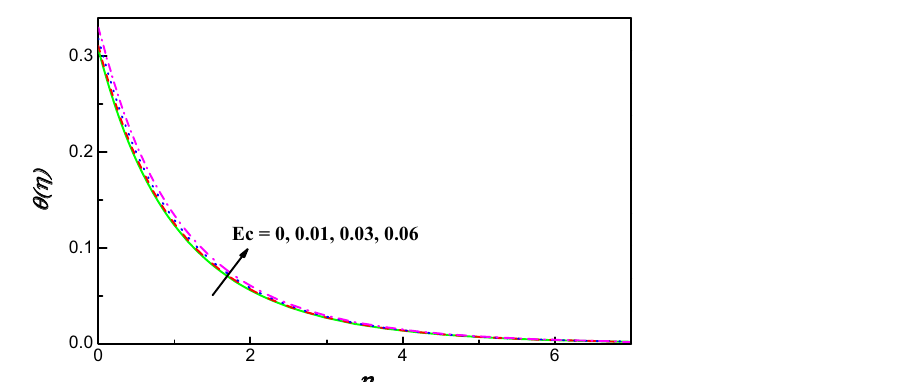
Figure 7. θ(η) variation vs. Ec .